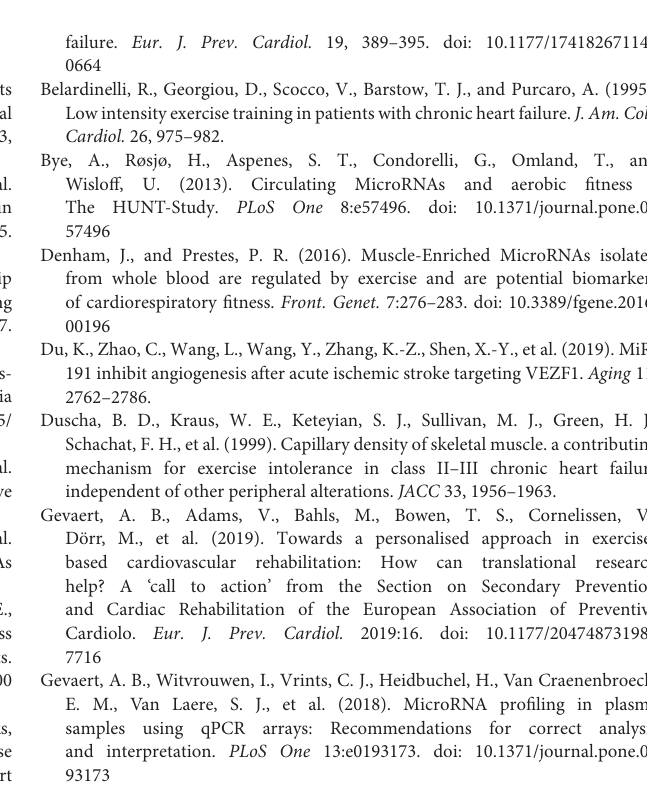
Supplementary Figure 1 | Training protocol including aerobic exercises (blue) and strength training (yellow). Latissimus dorsi, pectoral, triceps, deltoid, and quadriceps muscles were resistance trained. c-down, cool-down; ex, exercises; w-up, warming-up; reps, repetitions; R, respiratory compensation point at start; RCPi, respiratory compensation point at 4w CPET; RM, repetition maximum. Supplementary Figure 2 | Pearson correlation of baseline LVEF and creatinine with VO 2 peak, and baseline LVEF and relative miR-210 expression in ET ( n = 25) and UC group ( n = 21). ET, exercise training; LVEF, left ventricular ejection fraction; UC, usual care. Supplementary Figure 3 | Distribution of percent change in VO 2 peak in all participants ( n = 46). Gray, non-responders ( < 6% increase in VO 2 peak); black, responders ( ≥ 6% increase in VO 2